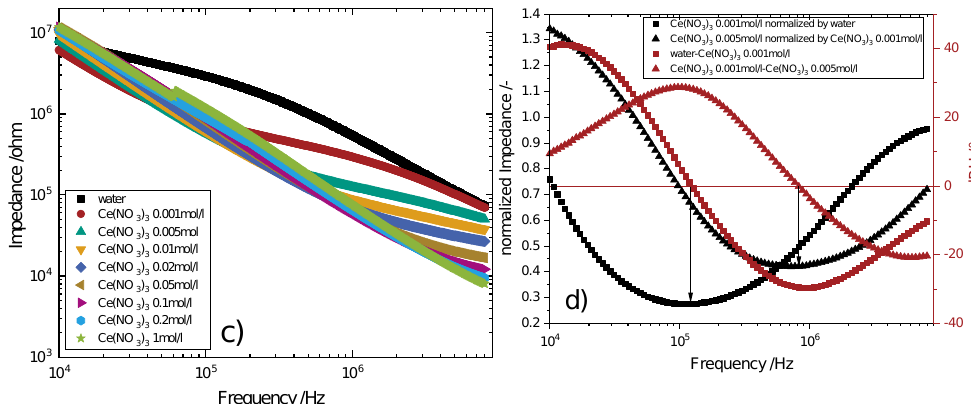
Figure 9. ( a , c ) Impedance over frequency for deionized water and cerium nitrate with different concentrations. ( b , d ) normalized impedance and phase shift over frequency. ( a , b ), glass-tube-reactor with a wall thickness of 0.2 mm and ( c , d ) glass-tube-reactor with a wall thickness of 0.5 mm. With tubular electrodes of 5 mm distance and 20 mm width for both glass-tube-reactors.